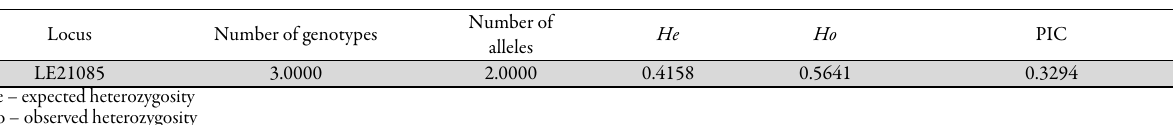
Number of He Ho PIC alleles